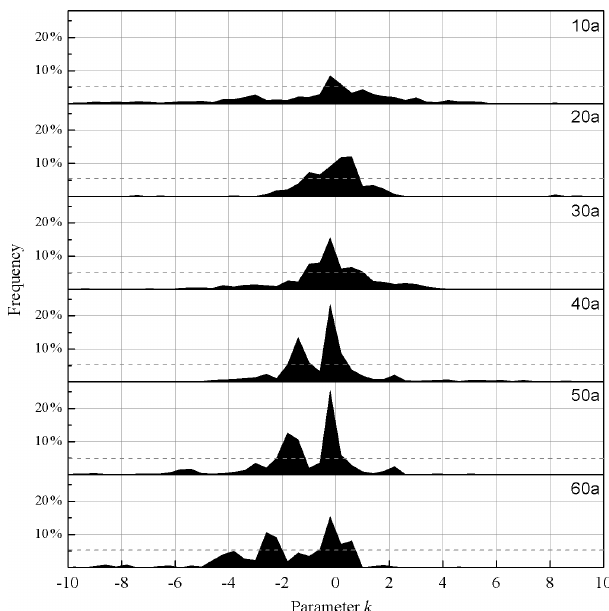
Figure 7. Statistical results of instability parameters for different subsequences lengths. The x axis is the value of parameter k , and the y axis is the statistical frequency for the subsequence length of 10a, 20a, 30a, 40a, 50a and